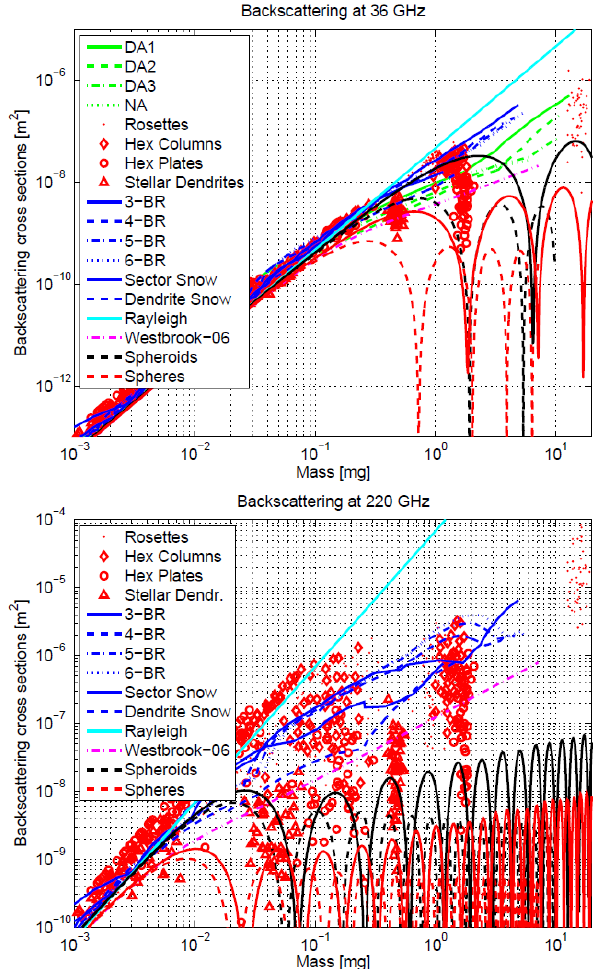
Figure 4. Backscattering cross sections for different habits as a function of ice crystal mass. Results from DDA data sets (Liu, 2008a; Petty and Huang, 2010; Tyynelä et al., 2011), for soft spheres and 0.6 axial ratio spheroids (following the snow densities proposed in Hogan et al. (2012) (dashed) and in Matrosov (2007) (continuous lines)) and the Rayleigh–Gans approximation accord- ing to Westbrook et al. (2006) (magenta dash-dotted) have been in- cluded.